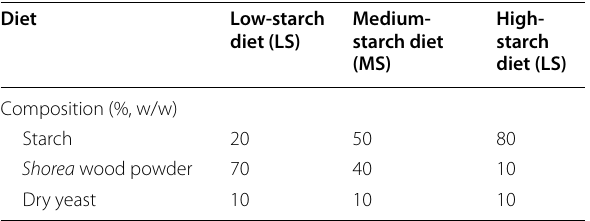
Table 1 Composition of artificial diets used in this study Diet Low-starch